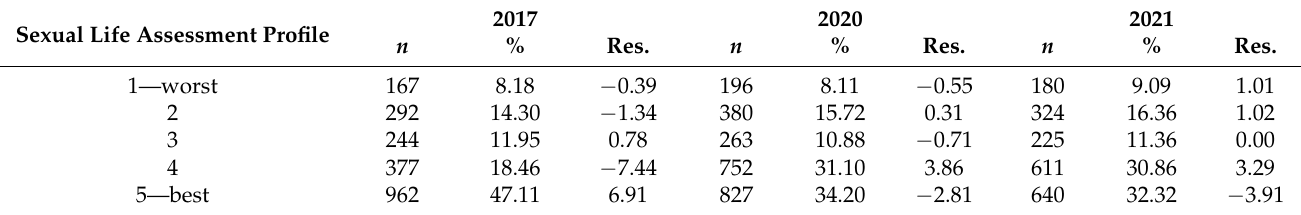
Table 4. Prevalence of sexual life assessment profiles in three